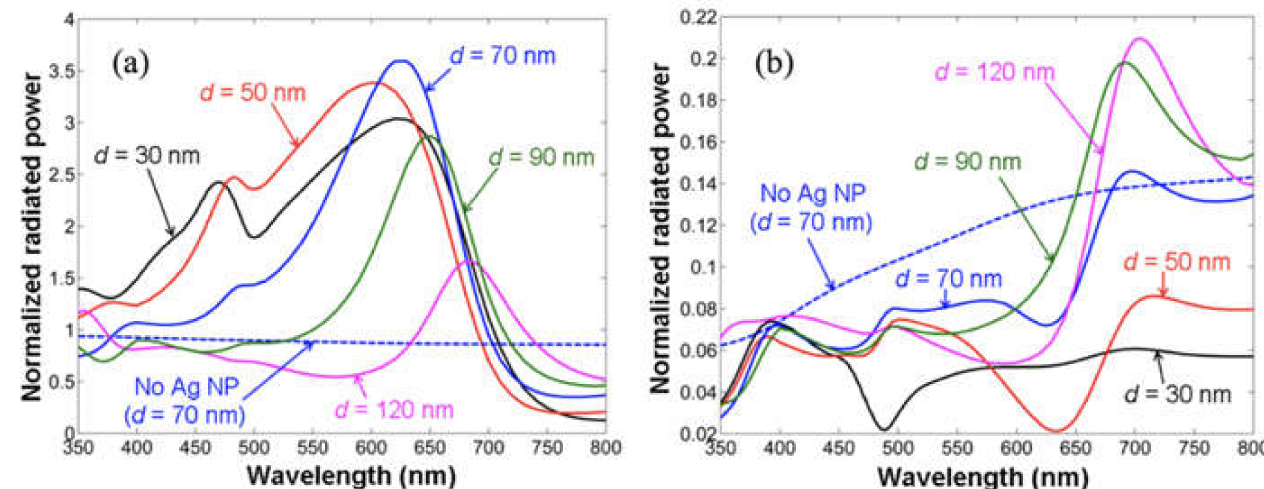
Figure 3. ( a ) Normalized downward and the ( b ) upward radiated powers of the NP–dipole coupling system as functions of wavelength for d = 30, 50, 70, 90, and 120 nm when the dipole is located exactly below the AgNP, i.e., at x = 0. The AgNP is surrounded by air in the upper-half-space. For comparison, the result in the case of no AgNP at the air/GaN interface with d = 70 nm is also plotted as the dashed curve. Reprinted with permission from [76]. Copyright 2018 The Optical